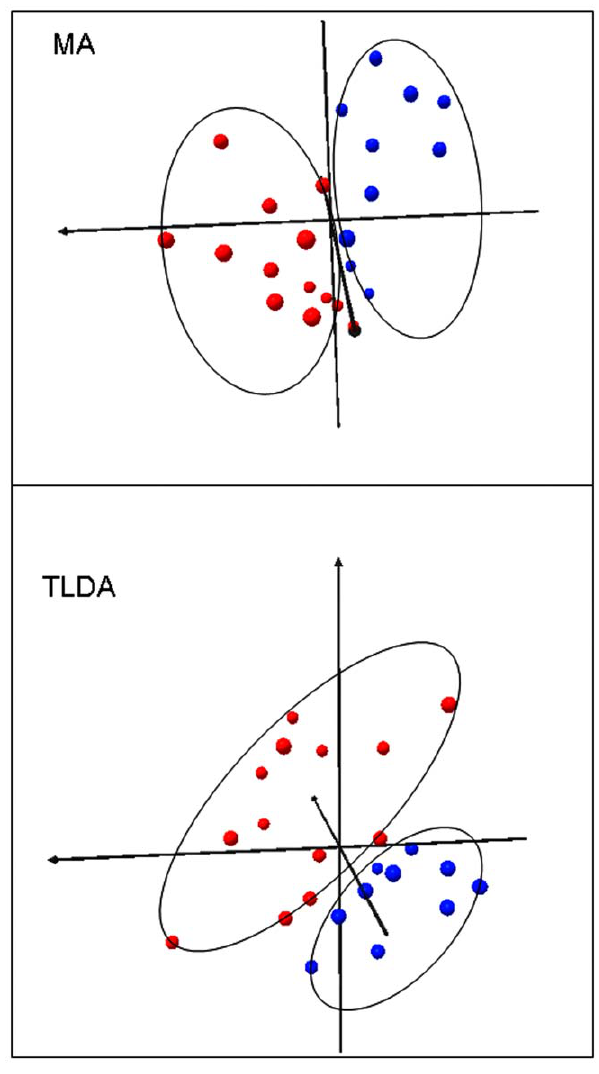
Figure 2. Multidimensional scaling in three dimensions (using Euclidean distances) of the microarray (MA) and TLDA (TLDA) gene expression data. The 10-gene classifier clearly separates the members of the NR (blue spheres) and CCR (red spheres) groups. 82–83 per cent of the variability is contained in these first three dimensions.